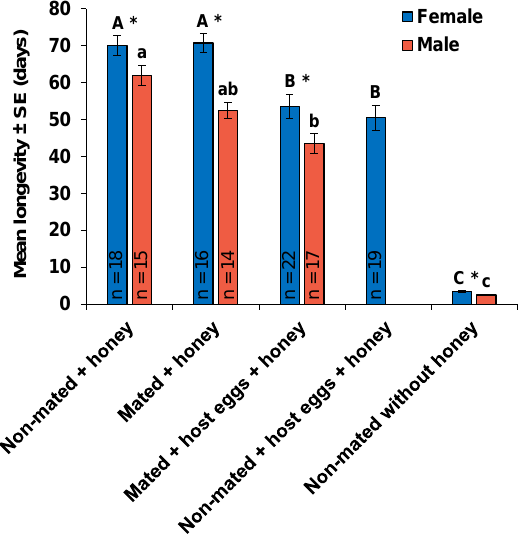
Figure 2. Mean ( ± SE) longevity of Ooencyrtus lucidus females and males in different treatments. n is the number of wasps that died naturally in each treatment excluding the ones that were stuck in honey. In the last treatment, non-mated without honey, all the initial number of wasps (n = 20) were used in the analyses. Significant differences are represented by capital letters for females and lower-case letters for males (Dunn’s Kruskal-Wallis multiple comparison, p < 0.05). The asterisks (*) represent significant differences between females and males within each treatment (Wilcoxon-Mann-Whitney test or t -test, p <